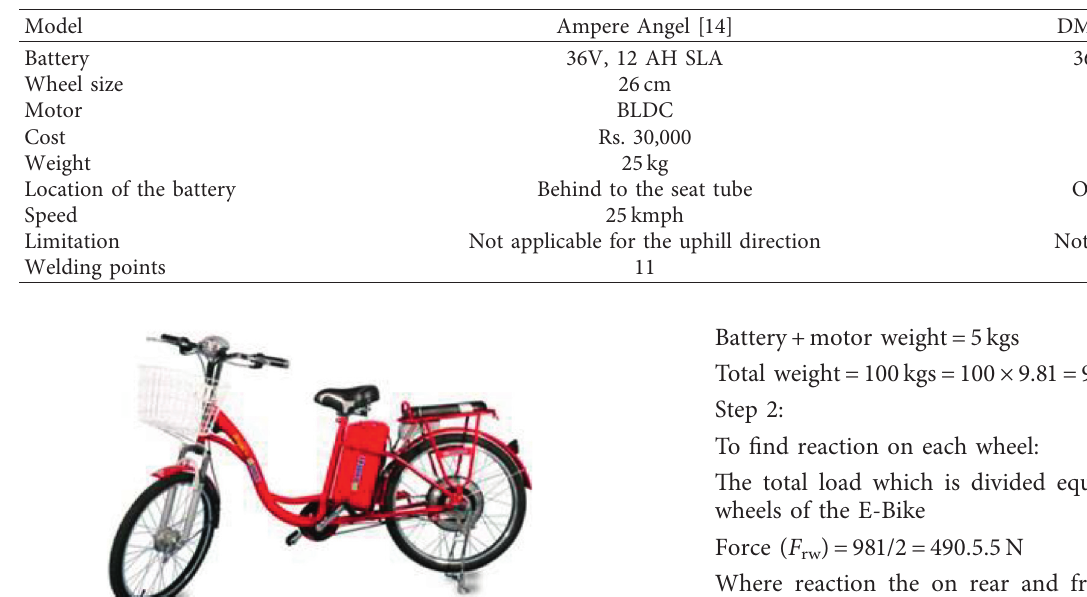
Table 1: Comprehensive analysis of existing E-Bike companies.